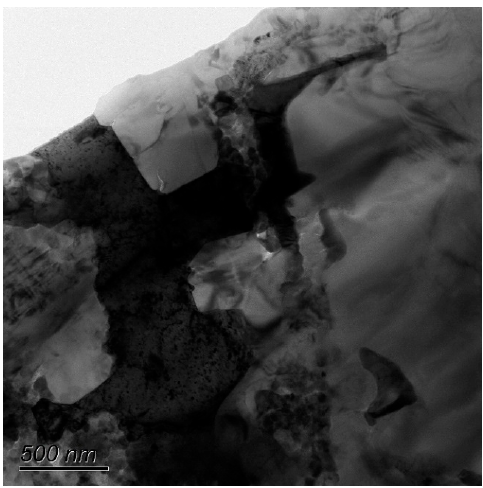
Figure 8. Bright field TEM micrograph of the Al 2 O 3 /30glass/30Cu f composite.